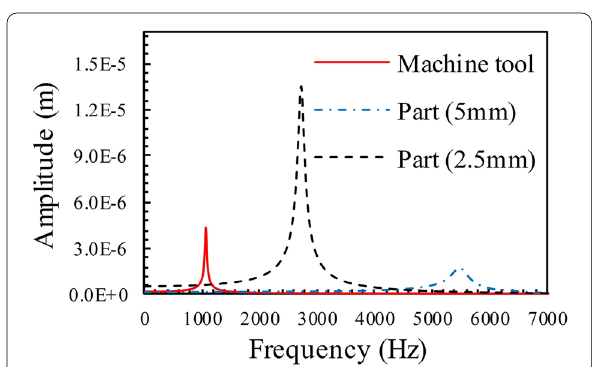
Figure 9 FRFs comparison of machine tool and part in critical